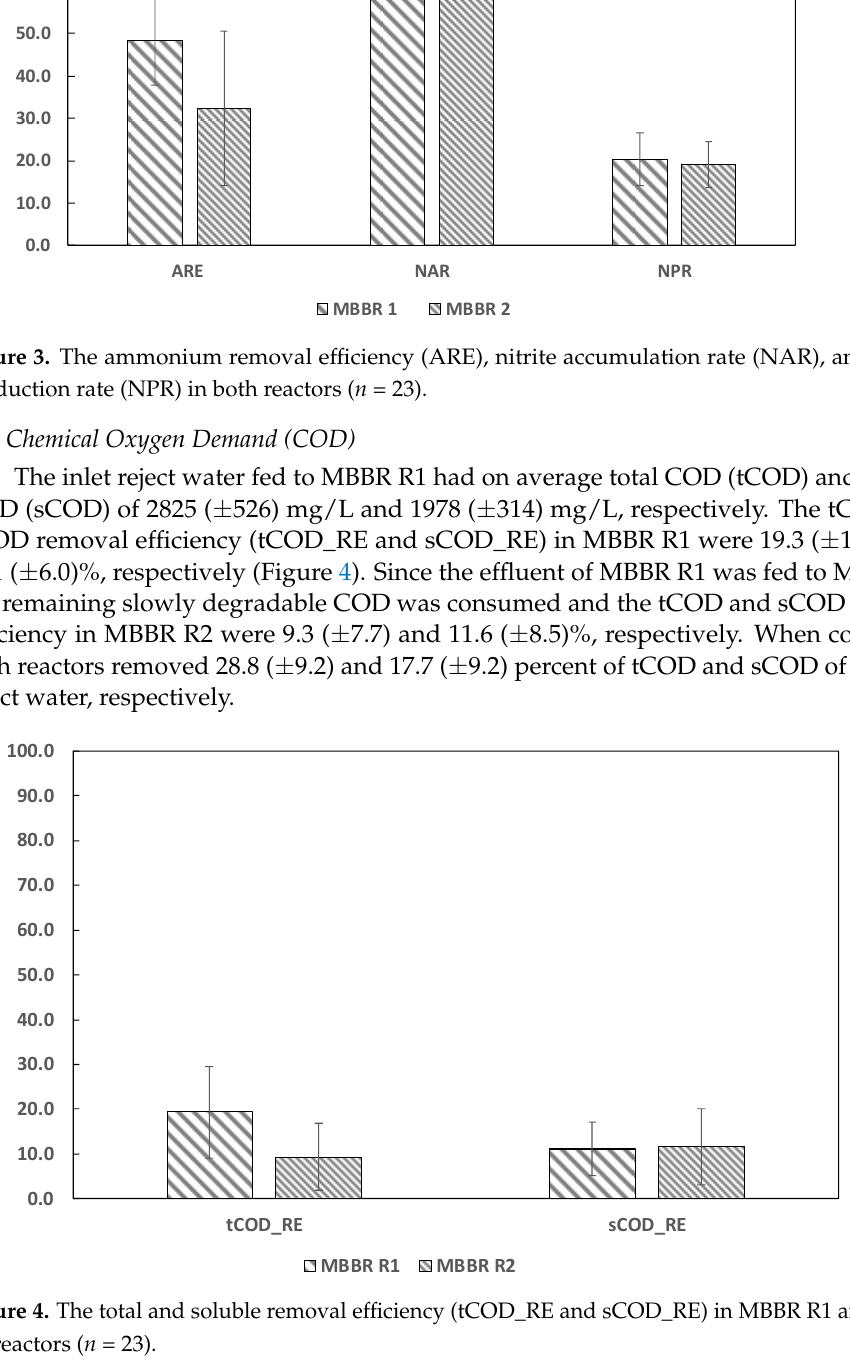
Figure 3. The ammonium removal efficiency (ARE), nitrite accumulation rate (NAR), and nitrate production rate (NPR) in both reactors ( n = 23).